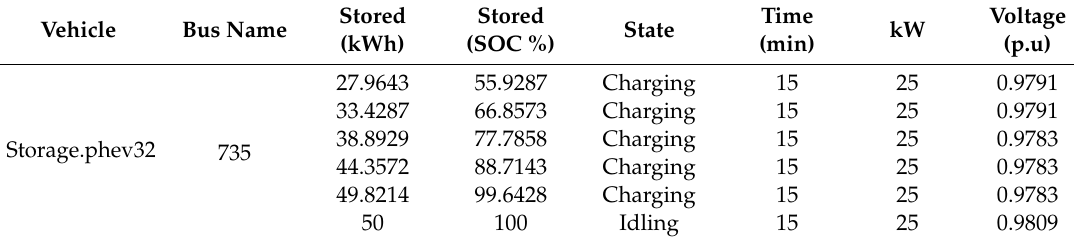
Table 7. Charging characteristics of a selected vehicle with a low priority